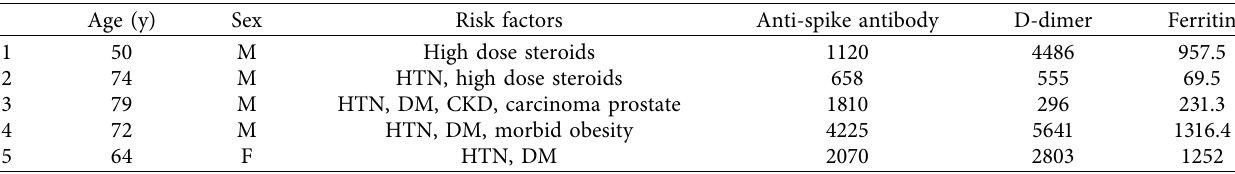
Table 4: Characteristics of non-surviving patients with high antibody